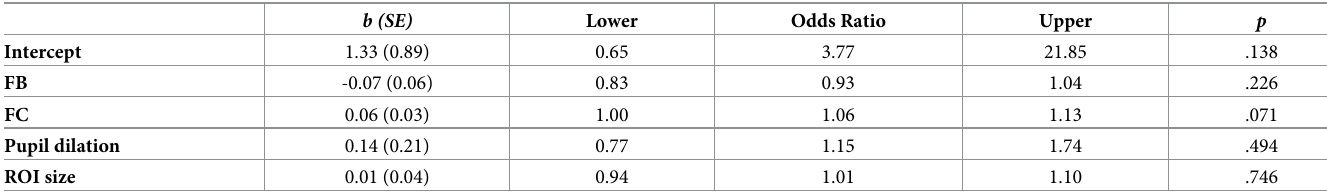
Table 3. Prediction of moral decision-making by FB, FC, and pupil dilation when controlling for ROI size using binary logistic regressions. b (SE) Lower Odds Ratio Upper p Intercept 1.33 (0.89) 0.65 3.77 21.85 .138 FB -0.07 (0.06) 0.83 .226 FC Pupil dilation ROI size 0.01 (0.04) 0.94 1.01